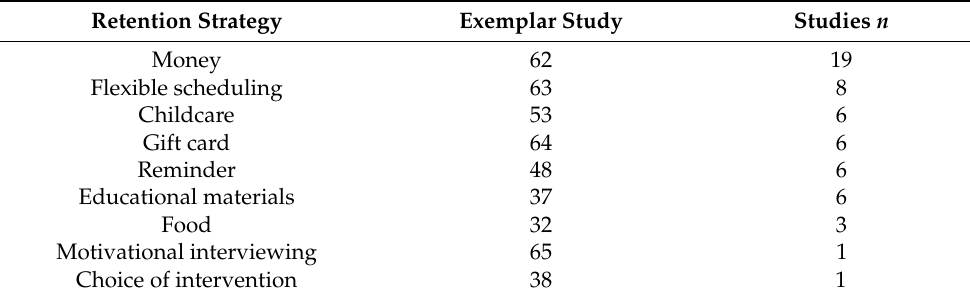
Table 5. Retention Strategies Across Research